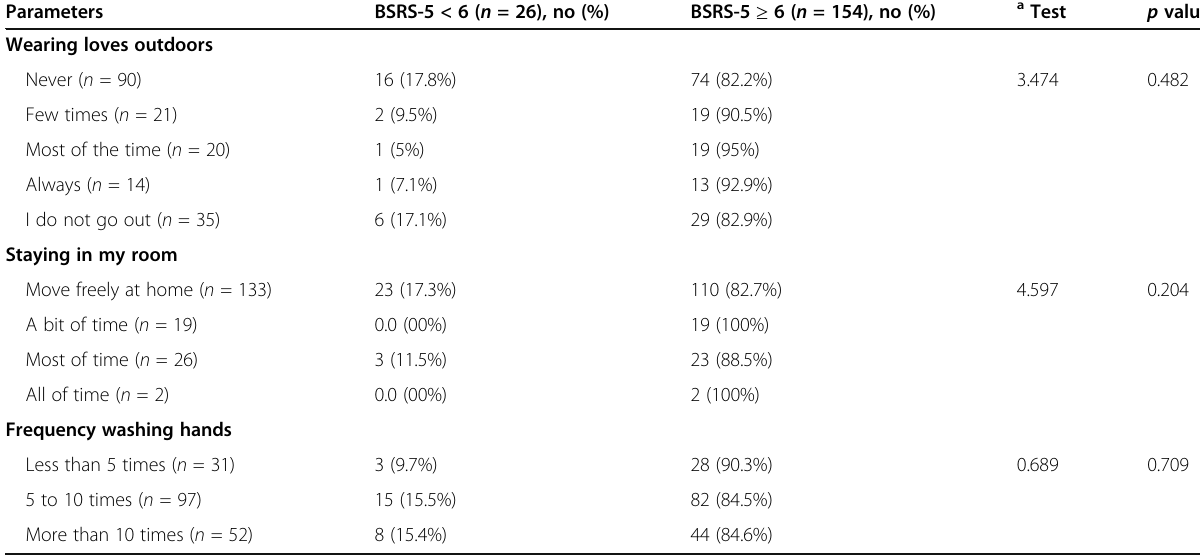
Table 5 Relation between different parameters and patients ’ mental health ( n = 180) (Continued)